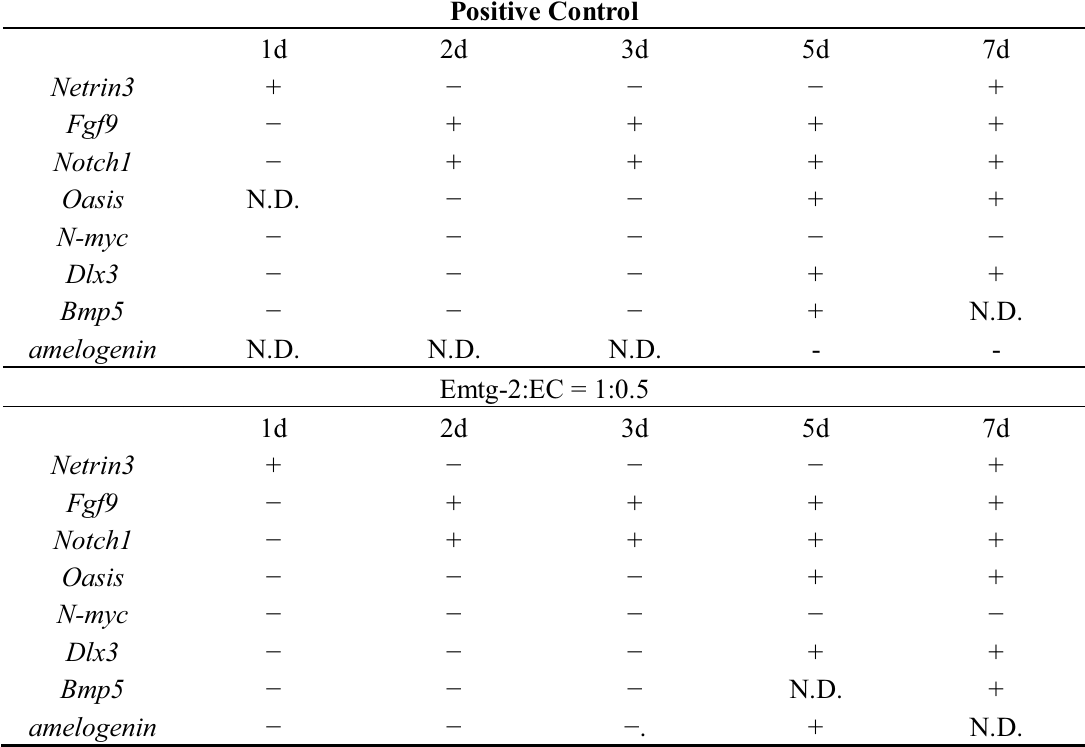
Table 6. Summary of gene expression patterns in reconstructed germs with EC and MT (positive control), emtg-2 cells and EC (ratio = 1:0.5) and MT, and emtg-2 cells and MT. Germs were cultured for one to seven